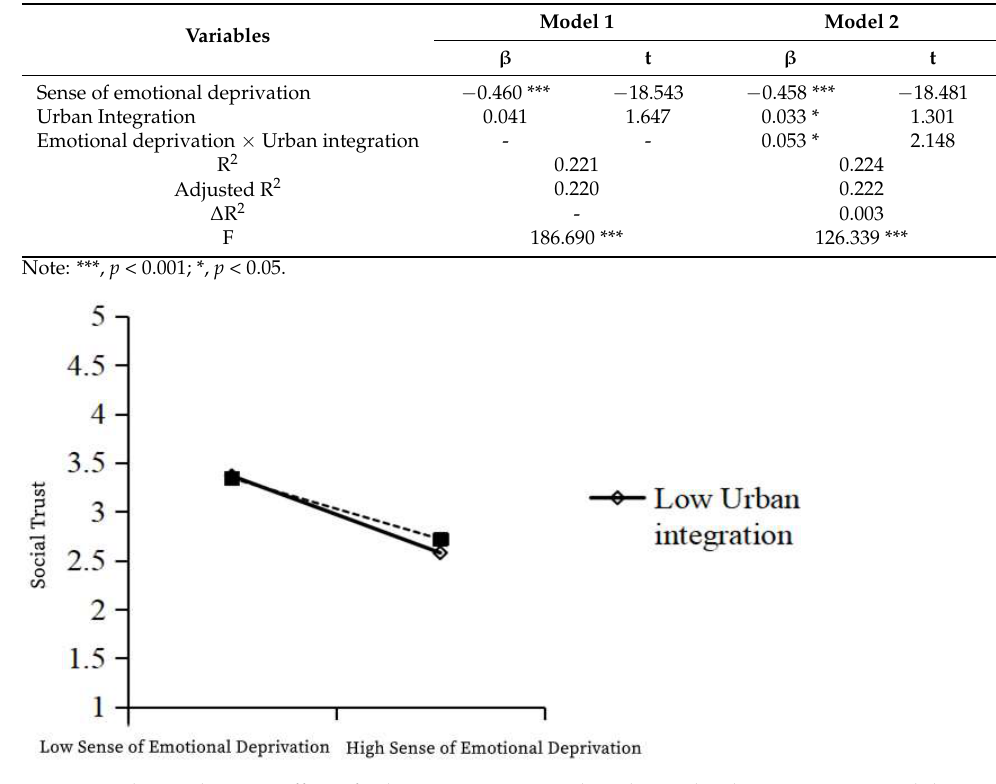
Figure 3. The moderating effect of urban integration on the relationship between emotional deprivation and social trust.